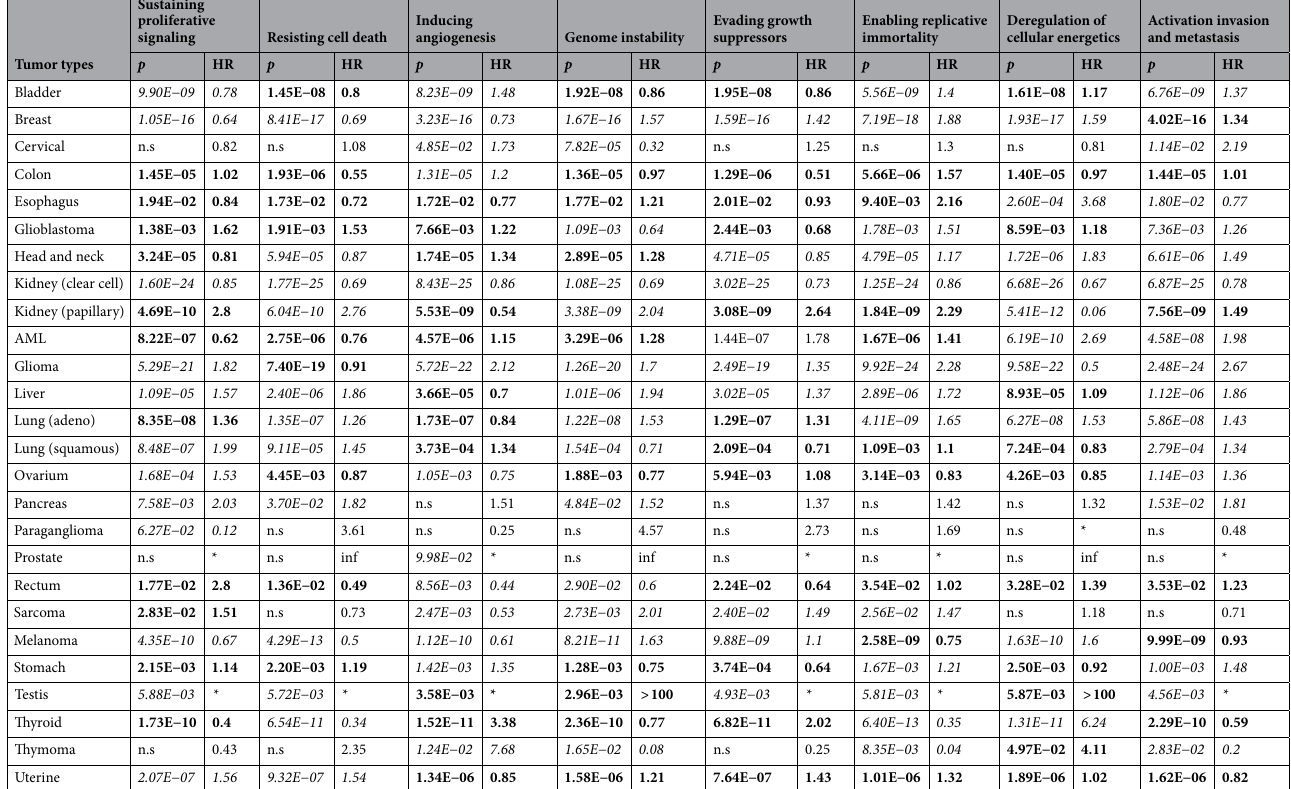
Table 2. Multivariate Cox regression analysis of hallmark gene signatures after including sex, race, stage, grade and age. Significant p (p < 0.05) and HR values in univariate and both uni- and multivariate survival analyses are bold and italics, respectively. HR values with asterisk (*) shows that there are not any events in one of the groups in the survival